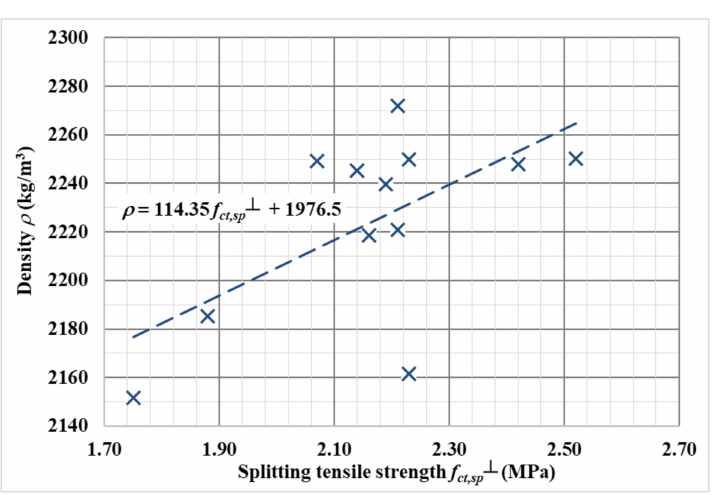
Figure 8. Functional dependence of splitting tensile strength (perpendicular to the filling direction) on